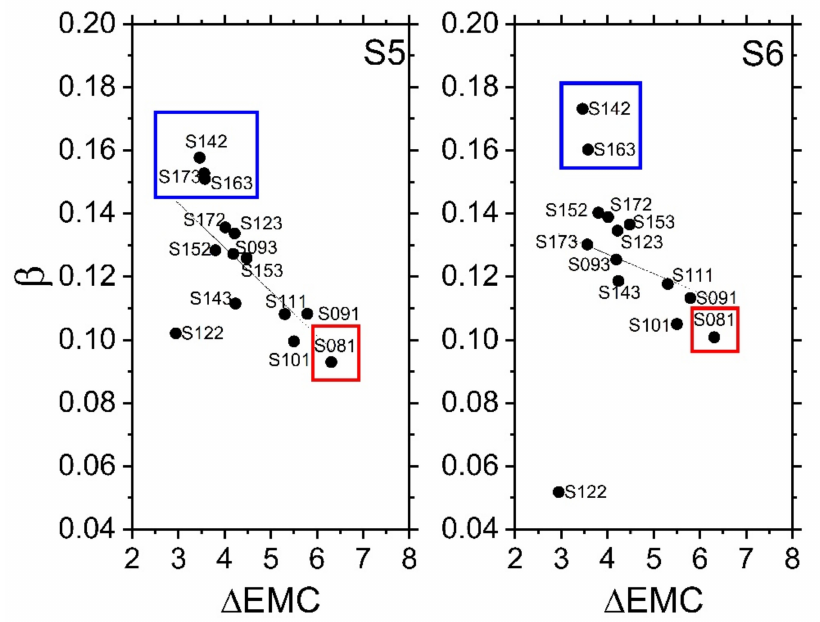
Figure 17. Coefficient of attenuation energy rate ( β , in absolute value) per sample along the beam by sensor S5 ( left ) and sensor S6 ( right ). The blue box highlights samples with the lowest mois- ture gradient during dryness. The red box, shows the opposite, those subjected to the highest moisture